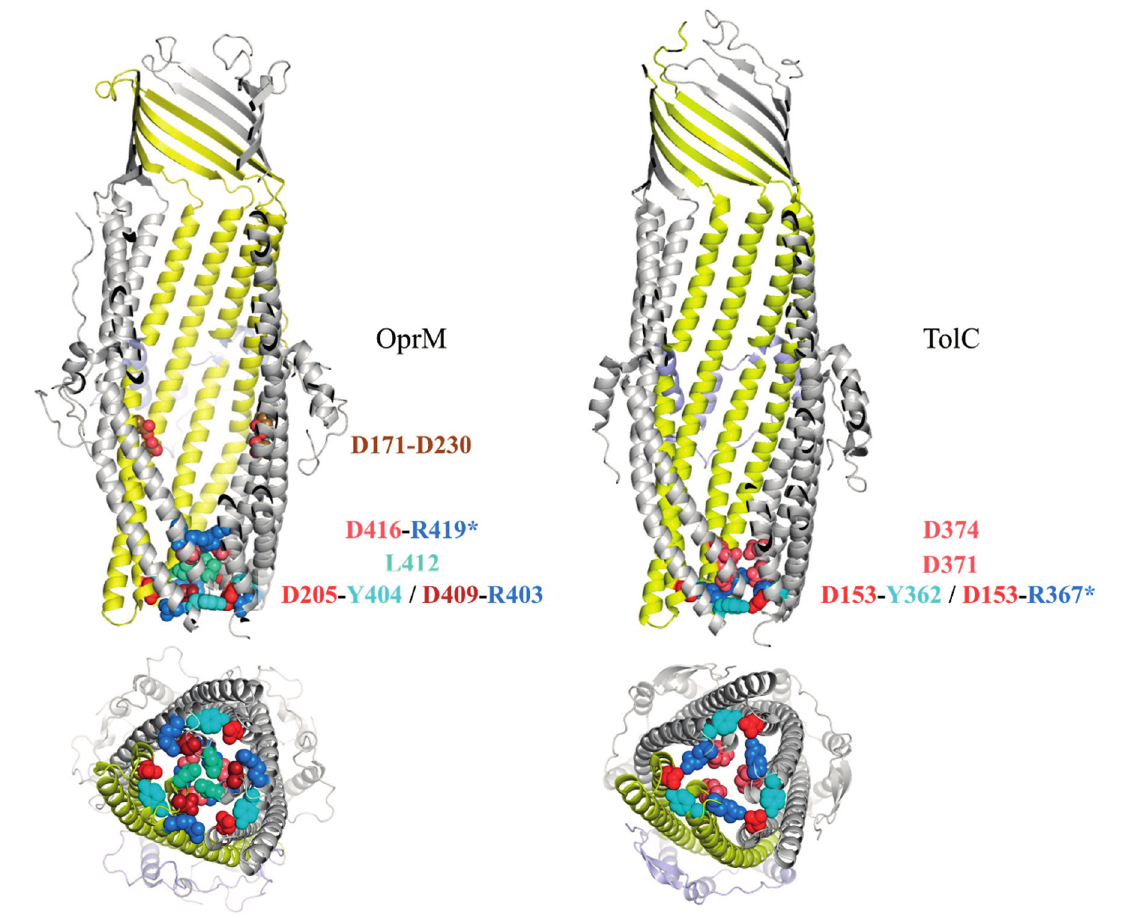
Figure 4. Comparison of the periplasmic domain of OprM and TolC. Amino